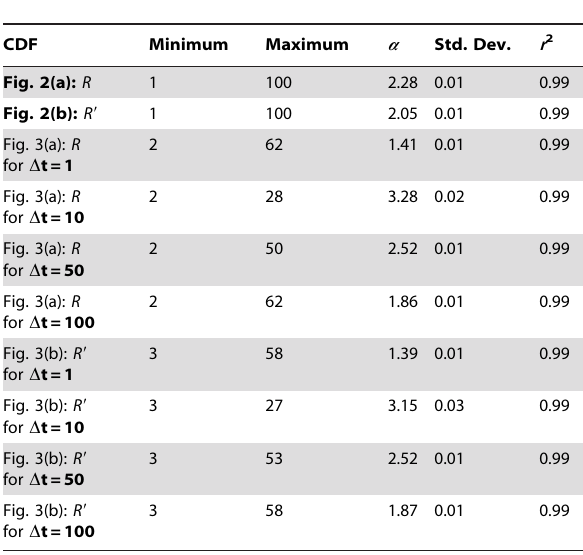
Table 2. The parameters for fitting CDFs shown in Figs. 2 and 3 (S&P500 Index in the US stock market) with R or R 9 ranging from ‘‘Minimum’’ to ‘‘Maximum’’.